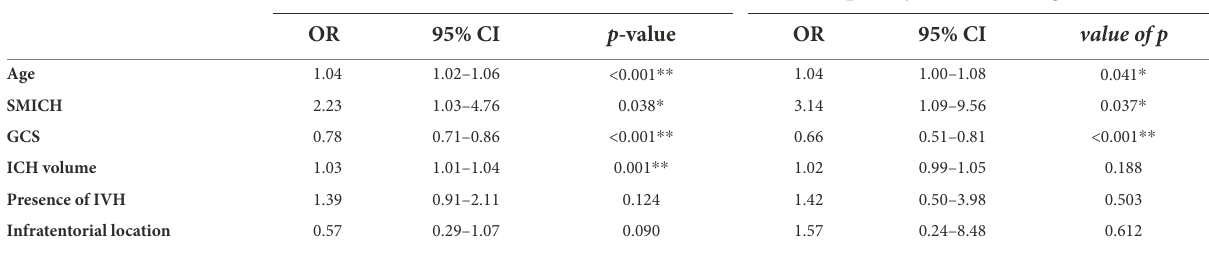
TABLE 4 Multivariable logistic regression model for factors associated with 90 day mRS ≥